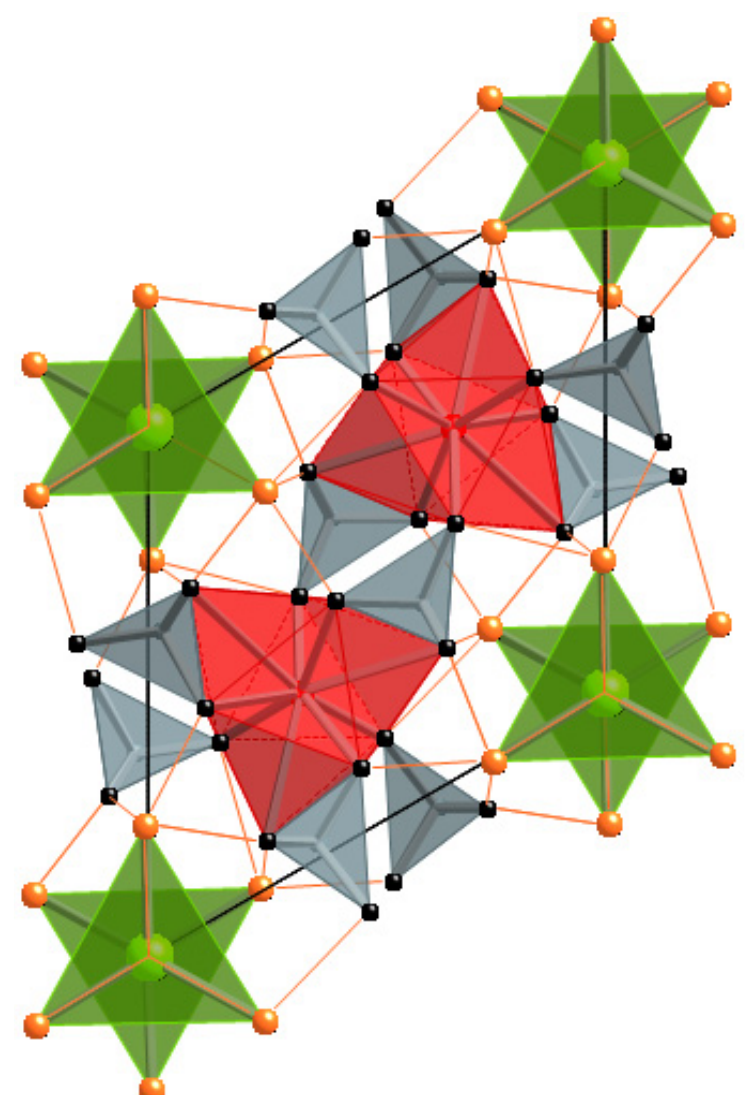
Figure 1. Structure of F-Ap (space group P 6 3 / m ) projected down [001]. The structure contains PO 4 tetrahedra (gray), Ca1O 9 polyhedra (red), and Ca2O 6 F polyhedra (not shown). The F ions (green spheres) are in the 6 3 channels and form F-Ca2 3 triangles (green). The Ca1 (red) and Ca2 (orange) sites contain mainly Ca ions. The O (black) ion sites are shown. The hexagonal unit-cell edges are outlined and their corners contain the 6 3 channels.